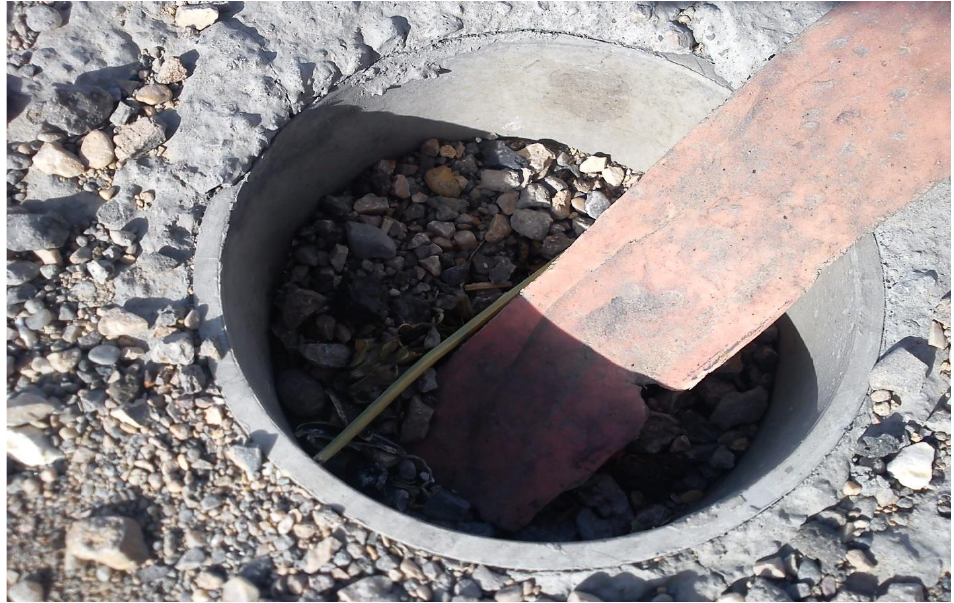
Figure 10. The structural elements of bridge No. 2.